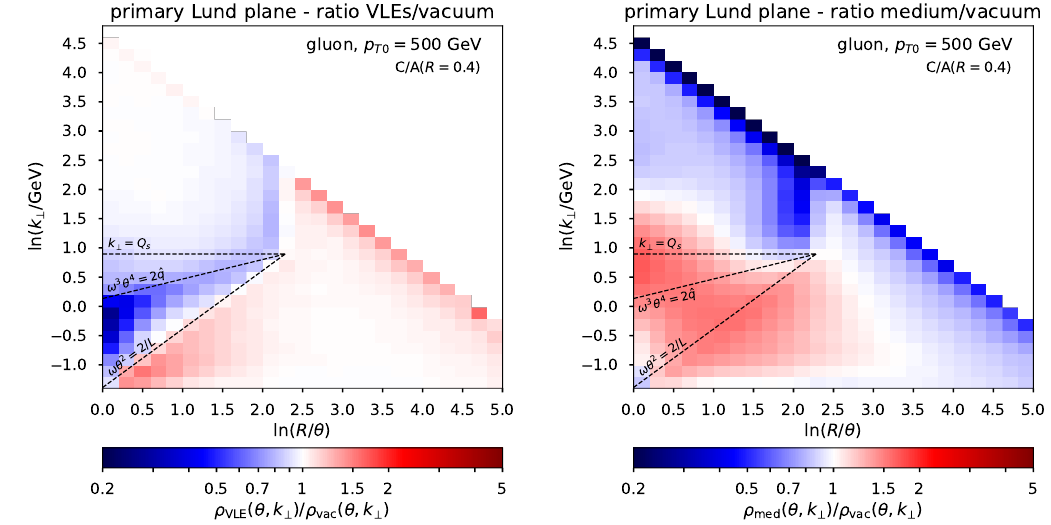
Figure 3 . E(cid:11)ect of the medium on the primary Lund plane density (cid:26) . The left plot show the ratio of the density obtained with VLEs, taking into account the kinematic constraints from the medium, to the vacuum reference. The right plot is the ratio of the full shower over the vacuum